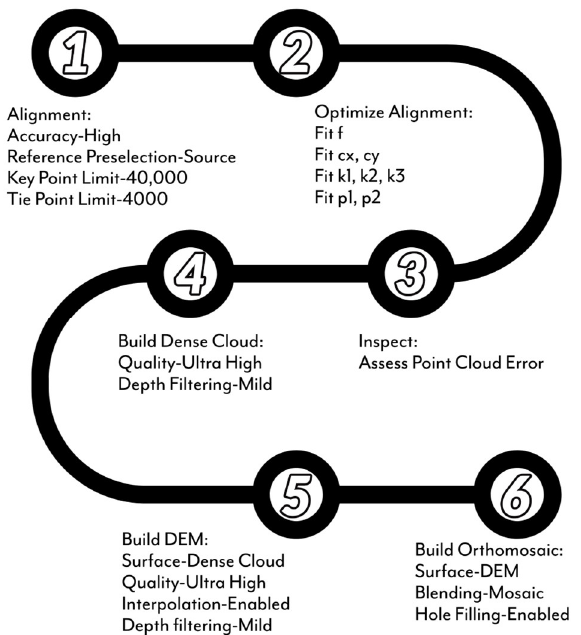
Figure 5. Image processing workflow in Agisoft Metashape.